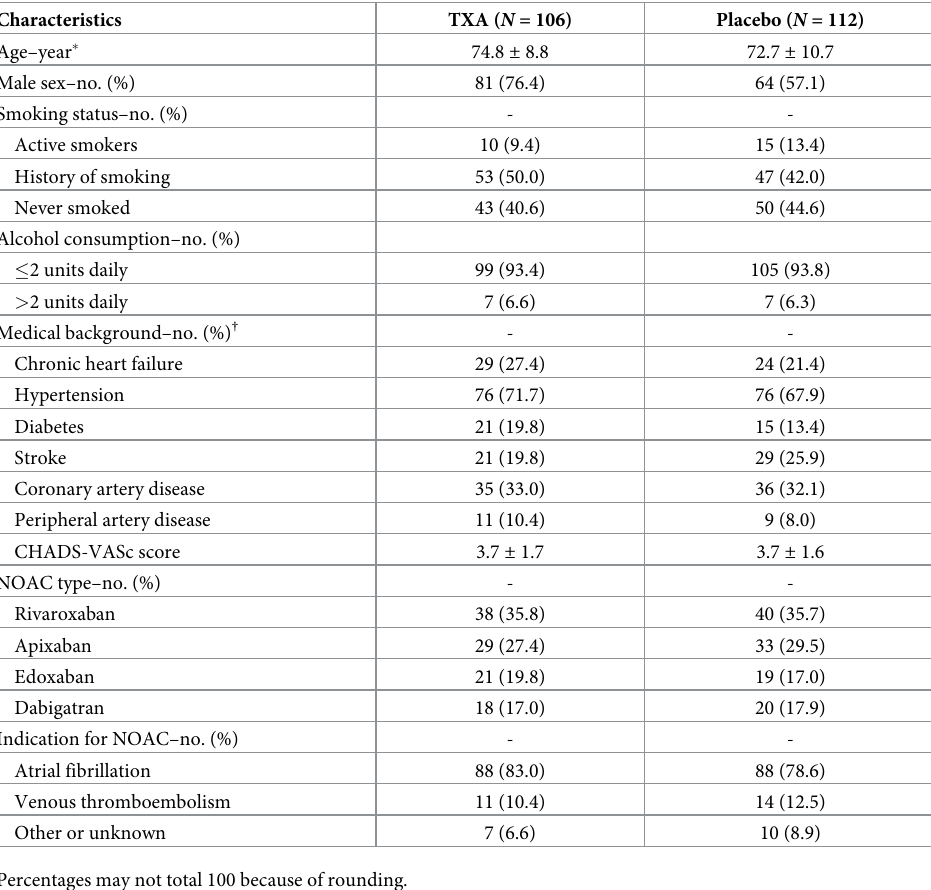
Table 1. Baseline characteristics of the